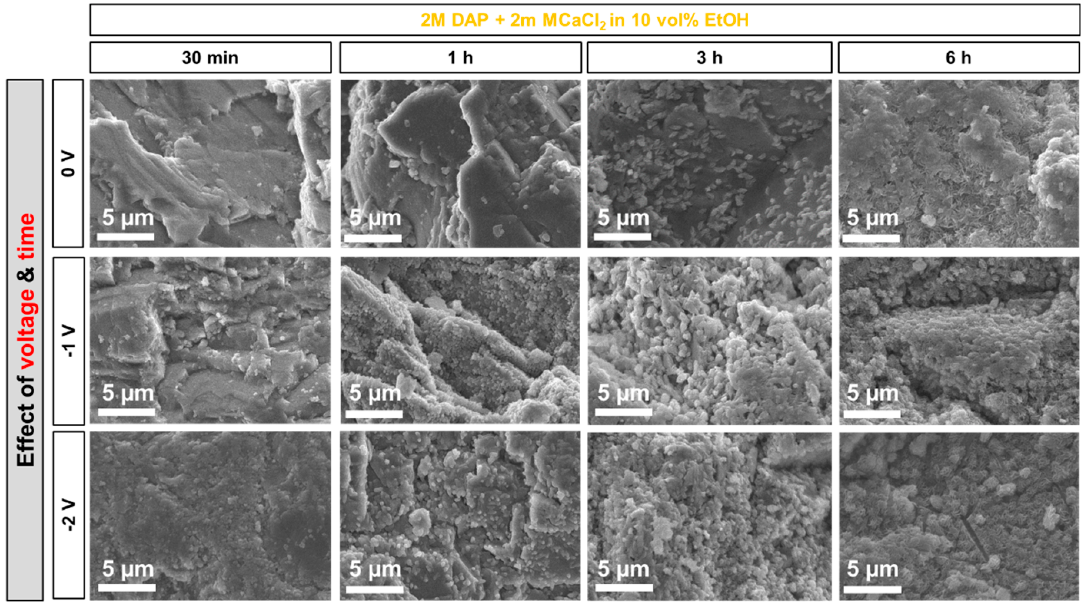
Figure 10. Effect of voltage and time on the morphology of the new CaP phases formed from the less-concentrated solution (2 M DAP + 2 mM CaCl 2 in 10 vol.% EtOH).